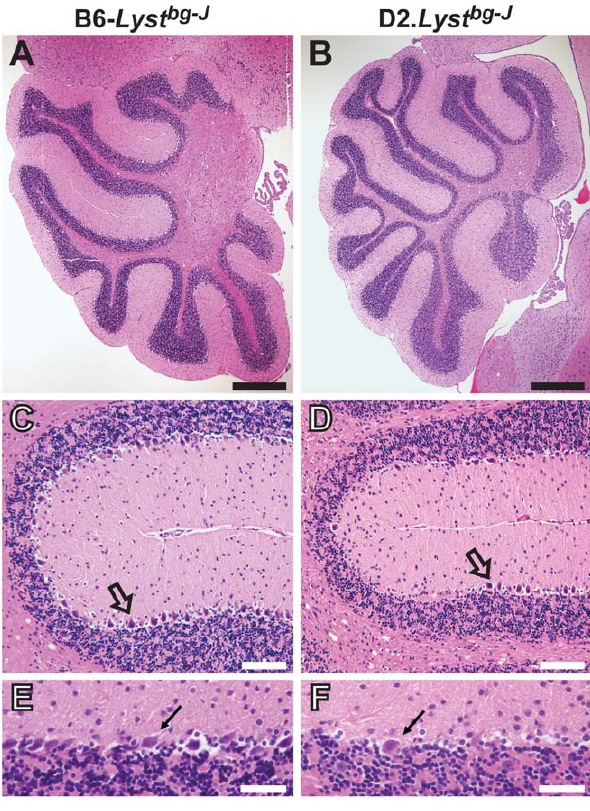
Figure 6. D2. Lyst bg-J mice exhibit Purkinje-cell degeneration. Mid-sagittal sections of H&E-stained cerebella revealing Lyst -mediated Purkinje-cell degeneration. (A, B) Low-magnification views of the cerebellar cortex, illustrating that D2. Lyst bg-J tissues exhibit no abnormalities of lobule formation or lobule size in comparison to B6- Lyst bg-J control tissues. Scale bars=0.5 m m. (C, D) Within fissures of the cerebellar cortex, D2. Lyst bg-J tissues exhibit a loss of Purkinje cells ( open arrows ) compared to B6- Lyst bg-J control tissues. Note that Purkinje cells of B6- Lyst bg-J mice form a continuous layer of closely spaced cells, whereas there is a large gap to the left of the open arrow in panel D from D2. Lyst bg-J mice that is devoid of Purkinje cells. Scale bars=100 m m. (E, F) Higher magnification images illustrating a decrease in the density of Purkinje cells ( arrows ) between the molecular ( above ) and granular-cell ( below ) layers in D2. Lyst bg-J cerebella compared to the same region in B6- Lyst bg-J age-matched controls. Scale bars=50 m m. All mice=17–20 months of